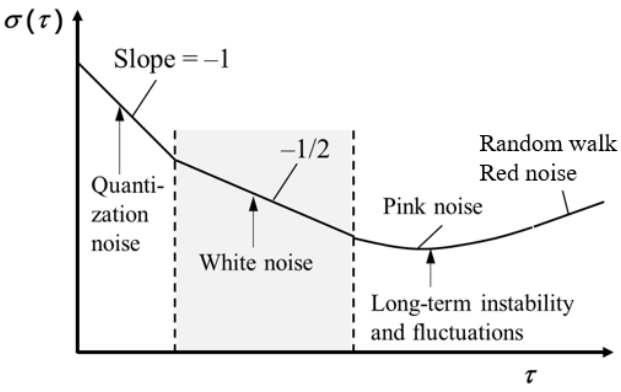
Figure 1. Schematic of different noise processes on an Allan deviation plot.